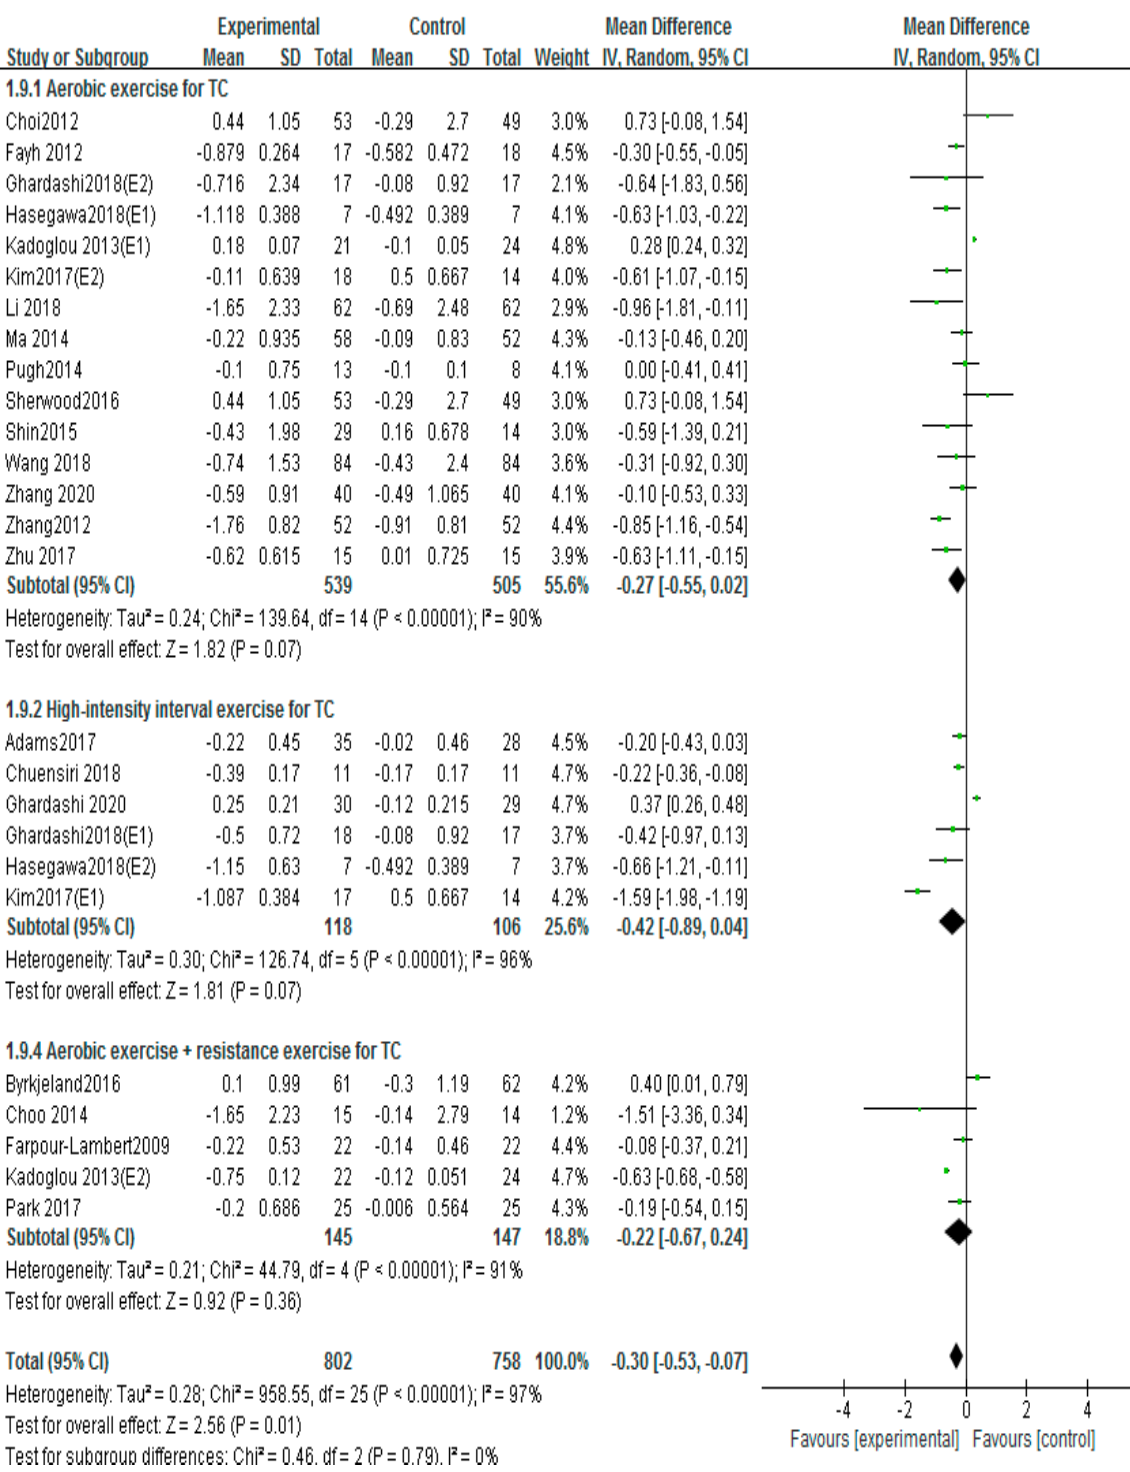
Figure 7. Subgroup analysis of TC effect size under different modes of exercise [12,13,16–21,23– 28,32,34,36,38–40,42,43].